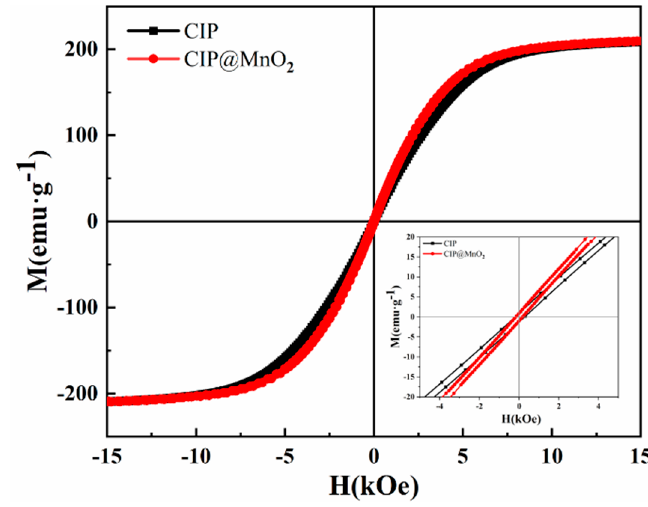
Figure 4. Hysteresis lines of CIP@MnO 2 composites and CIP.